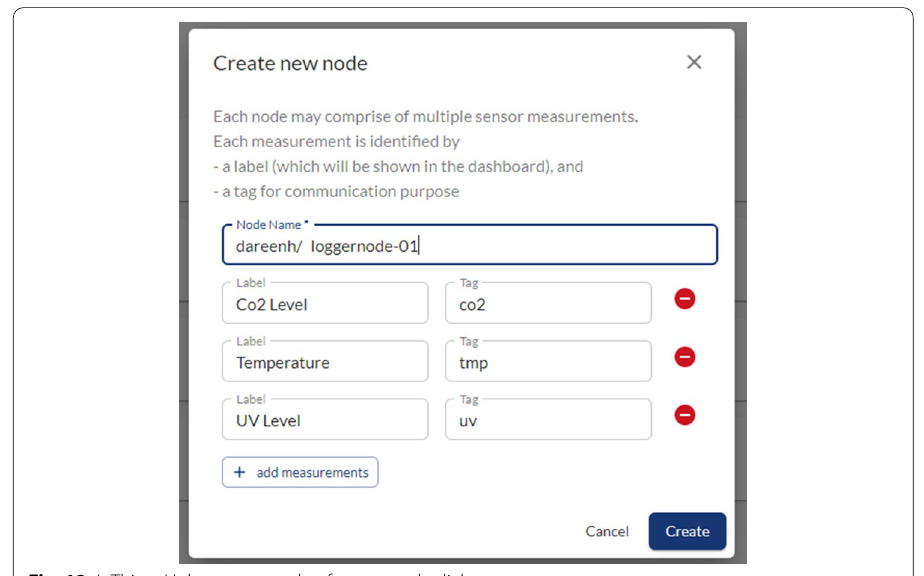
Fig. 12 IoThingsHub—an example of create node dialog